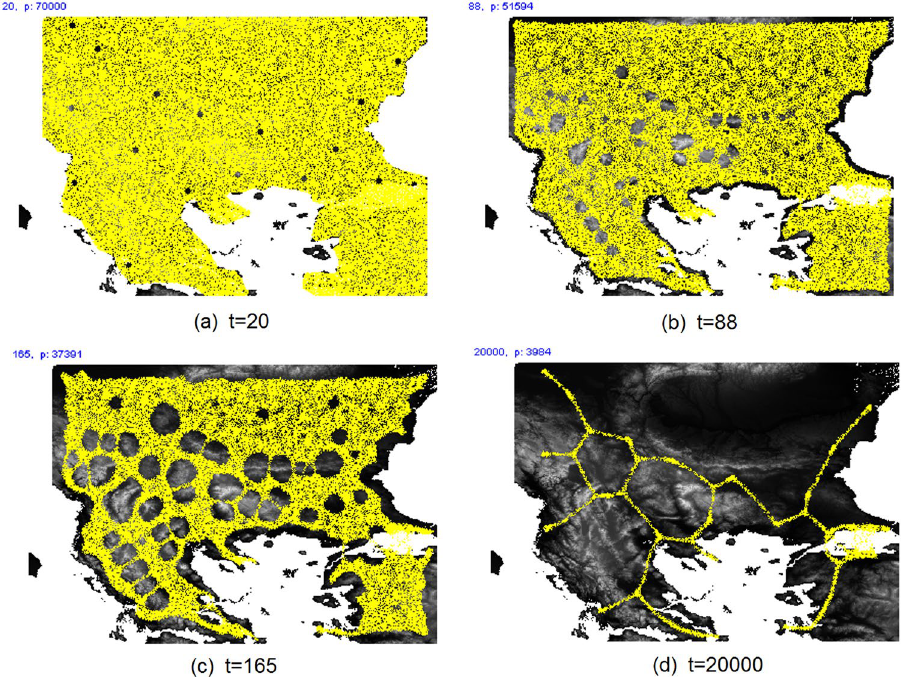
Figure 11. Example evolution of a single experiment under influence of landscape height, particle positions indicated by yellow (online). ( a ) Model Plasmodium inoculated as a single mass completely occupying available locations, ( b ) as adaptation progresses, pores begin to form in the virtual material, ( c ) pores predominantly form in areas of higher landscape height, ( d ) adaptation continues to minimise network (Simulation results from custom Java simulation of slime mould (https://www.processing.org/) by author J.J.).